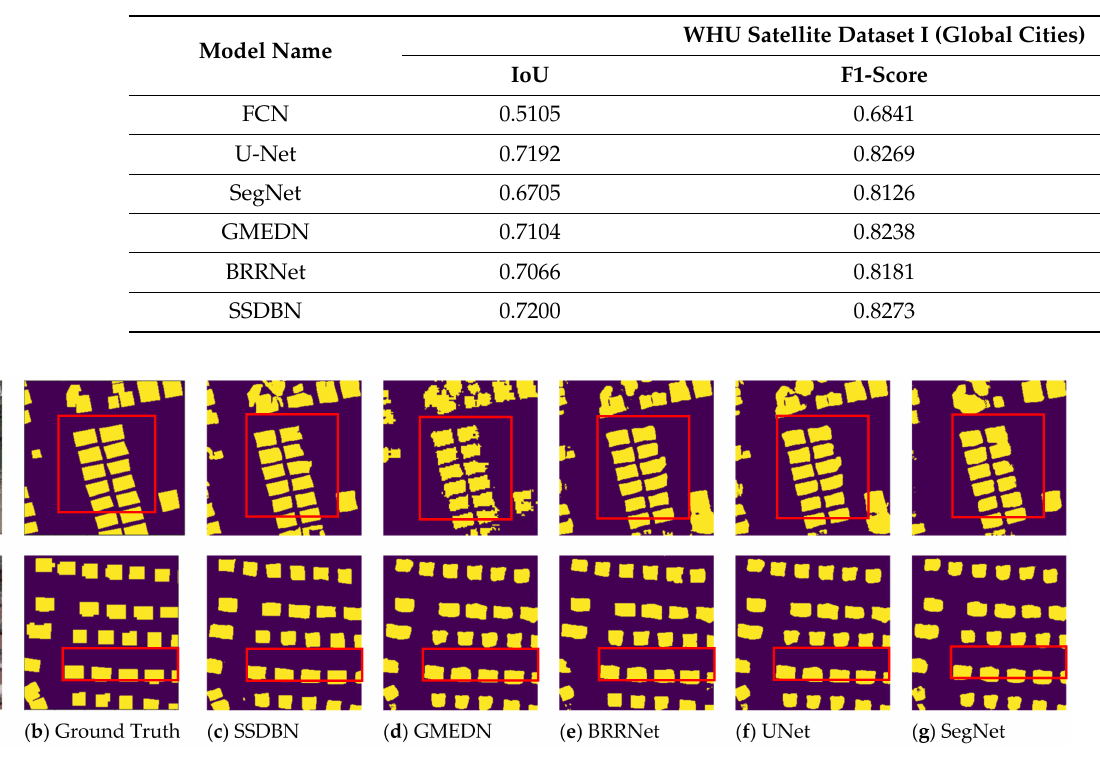
Figure 8. Prediction of different models with the WHU Satellite Dataset I (global cities). ( a ) Input image; ( b ) ground true; ( c ) the result of our method of SSDBN; ( d ) the result of GMEDN; ( e ) the result of BRRNet; ( f ) the result of UNet; ( g ) the result of SegNet. The red boxes indicate the more obvious extraction